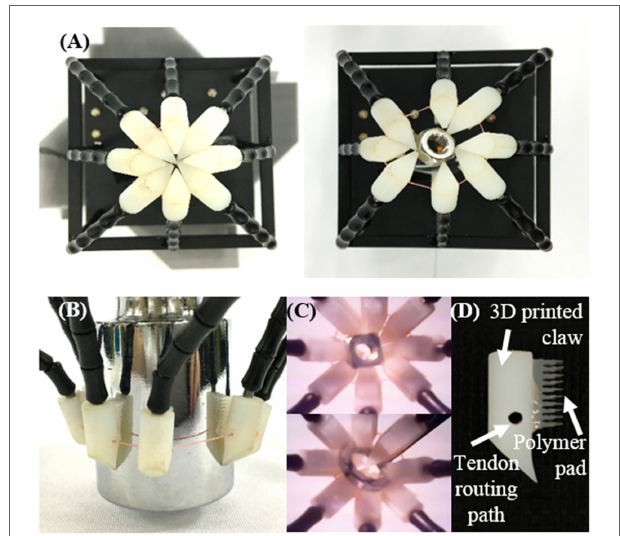
FigUre 7 | Design and performance of the claw . (a) Left, closed state of the claw. All claws are closed in one point. Right, claw gripping a small nut. (B) Claw gripping a large smooth-surfaced object. (c) Images of gripping captured by the embedded camera. (D) Claw design. The polymer pad is attached to the 3D-printed claw.